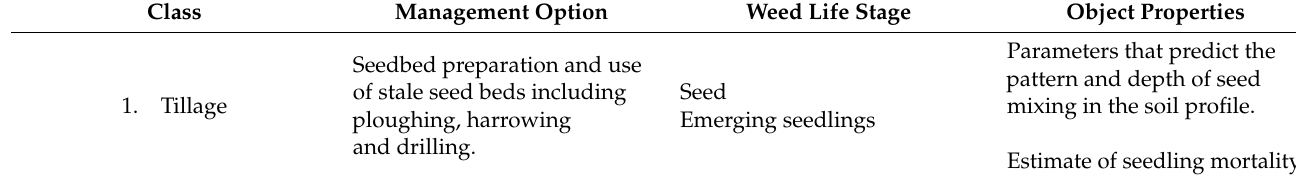
Table 1. Summary of classes associated with the first four control